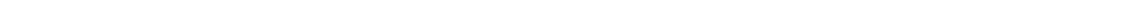
Fig. 5 Examples of unannotated protein-coding regions discovered. Gray lines indicate introns, black thick lines are UTRs, colored boxes are coding regions (color indicates reading frame). Novel peptides are shown as red boxes unless they are in different reading frames. a Pseudogene TATDN2P1 protein identi fi ed with two novel peptides linked in the same open reading frame. b LncRNA ENSG00000267943 protein identi fi ed with four novel peptides. c An alternative reading frame protein of the DRAP1 gene was identi fi ed with four novel peptides. The color of exons and novel peptides indicates reading frame. Exons and peptides in same colors (darker shade for peptides) are in the same reading frame. d Alternative protein N terminus for gene C1orf122 was identi fi ed with two novel peptides. e Two novel peptides serving as evidence for the existence of “ retained intron ” translation for the EGFR gene. f Extended exon protein variant of gene MPRIP was identi fi ed with three novel